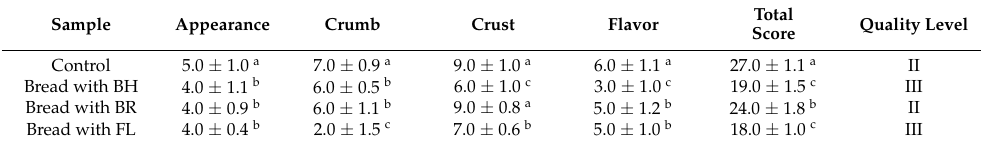
Table 9. Sensory evaluation of breads. Sample Appearance Crumb Crust Flavor Total Score Quality Level